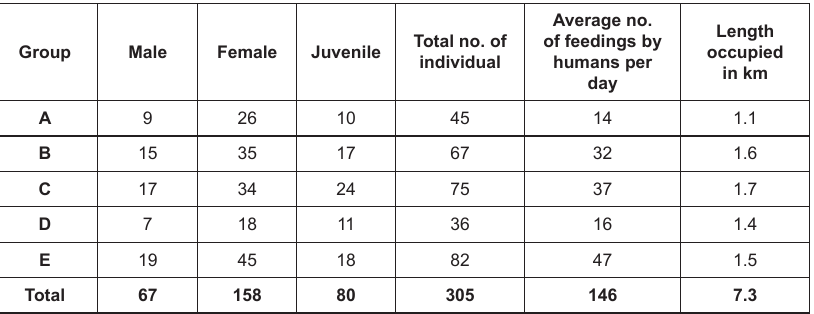
Table 1. Average number of Rhesus Macaque sighted on NH-7 along Pench Tiger